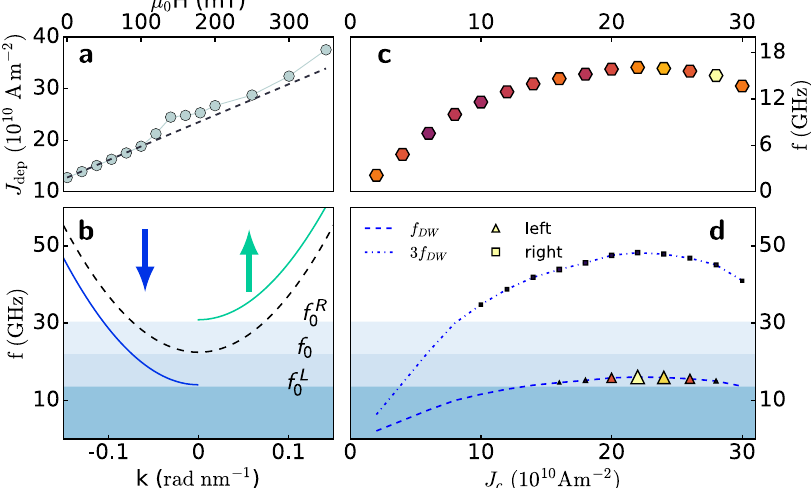
Figure 5. DW rotation and SW dynamics in the presence of an external field. ( a) Depinning current J function of a counter-acting external field applied along the − ˆ z direction. The dashed line represents the theoretical prediction made using the one-dimensional model (3). ( b) Splitting of the dispersion relation branches in the positive and negative directions with respect to the DW caused by the application of an external field, as prescribed by equation (2). ( c ) DW rotation frequency as a function of the applied current when an external field of 300 mT is applied. ( d ) SW propagation observed in the regions distant from the DW on the left (triangles) and on the right (squares), as indicated in Fig. 2b. The size of the symbols express the SW amplitude. The SW propagates to the left at f DW , whereas it propagate to the right at 3 f DW